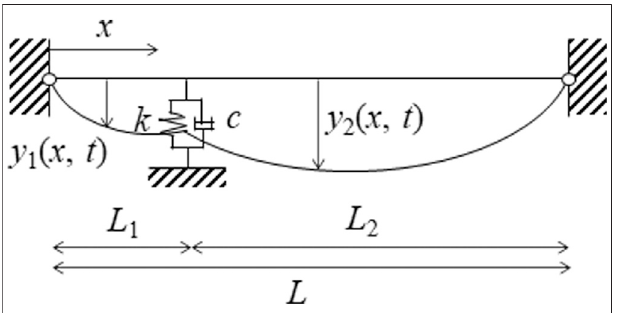
FIGURE 1 | A model for a cable with a